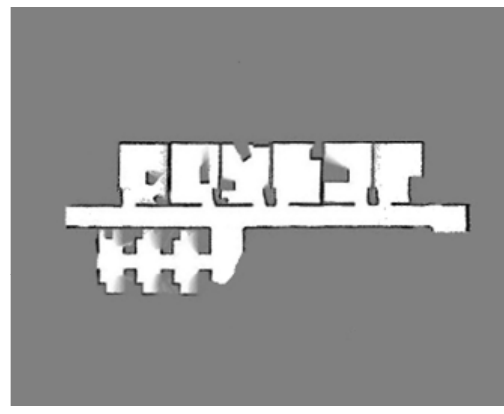
Fig. 6. The successful merging of map 2 and map 3 (best hypothesis acceptance indicator